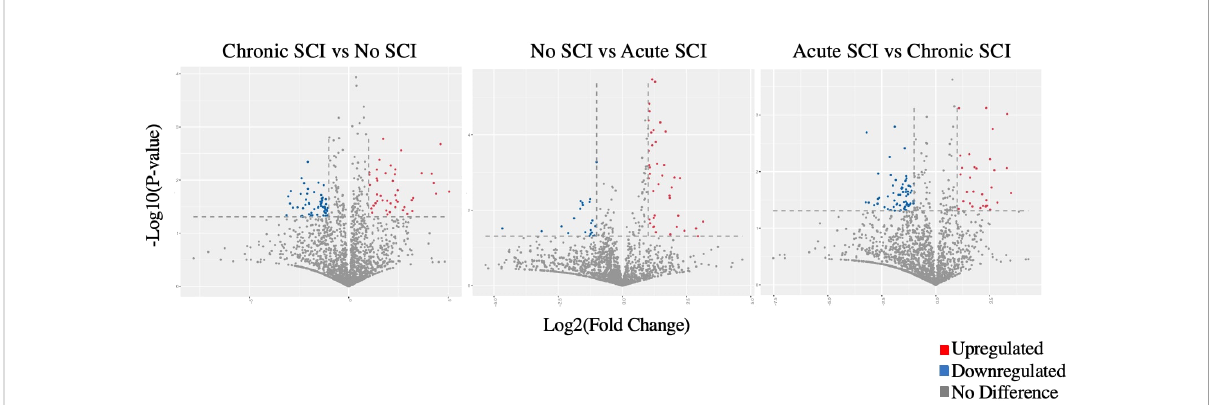
FIGURE 1 Volcano plots comparing Log2 (fold change) of miRNA expression values for participants who have a chronic SCI versus no SCI, no SCI vs acute SCI, and acute SCI vs chronic SCI. Signi fi cantly upregulated genes shown in red, signi fi cantly downregulated genes shown in blue (p<0.05). Some dots may represent more than one data